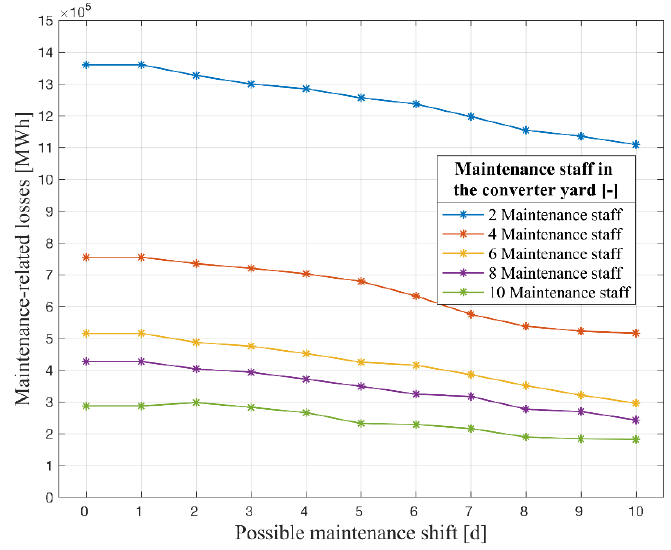
Figure 12. Maintenance-related losses for the total operation time of the HVDC system over possible maintenance shift for different number of maintenance staff in the converter-yard.